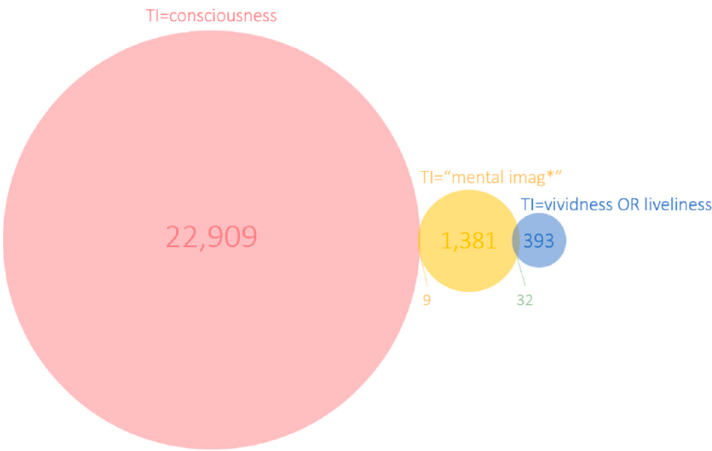
Figure 2. Venn diagram of the co-occurrence of terms in the title field (TI).